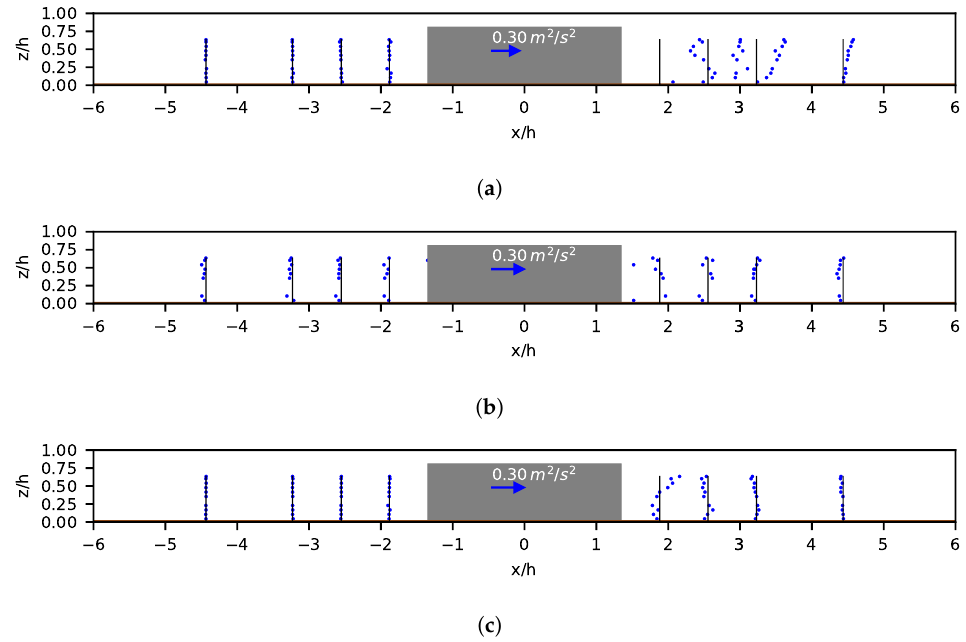
Figure 13. Vertical profiles of the Reynolds shear stresses along the pier’s mid-plane for Exp . 1 U Fbed . ( a ) Reynolds shear stresses ( u (cid:48) v (cid:48) ). ( b ) Reynolds shear stresses ( u (cid:48) w (cid:48) ). ( c ) Reynolds shear stresses ( v (cid:48) w (cid:48) ).